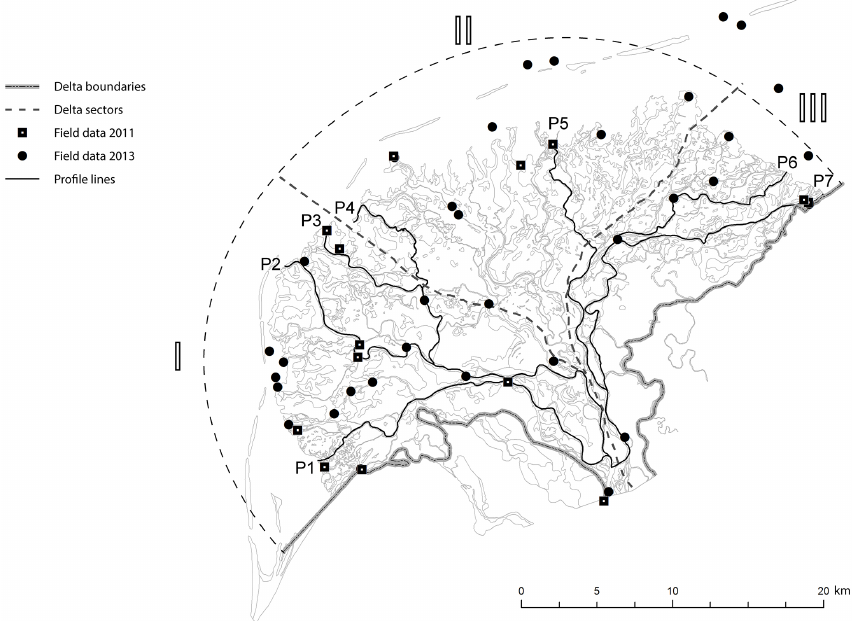
Figure 1. Selenga River delta ( P 1– P 7 – distributaries used for (cid:49)S calculations; I, II, III – Selenga Delta sectors; dots represent the locations of in-situ SSC